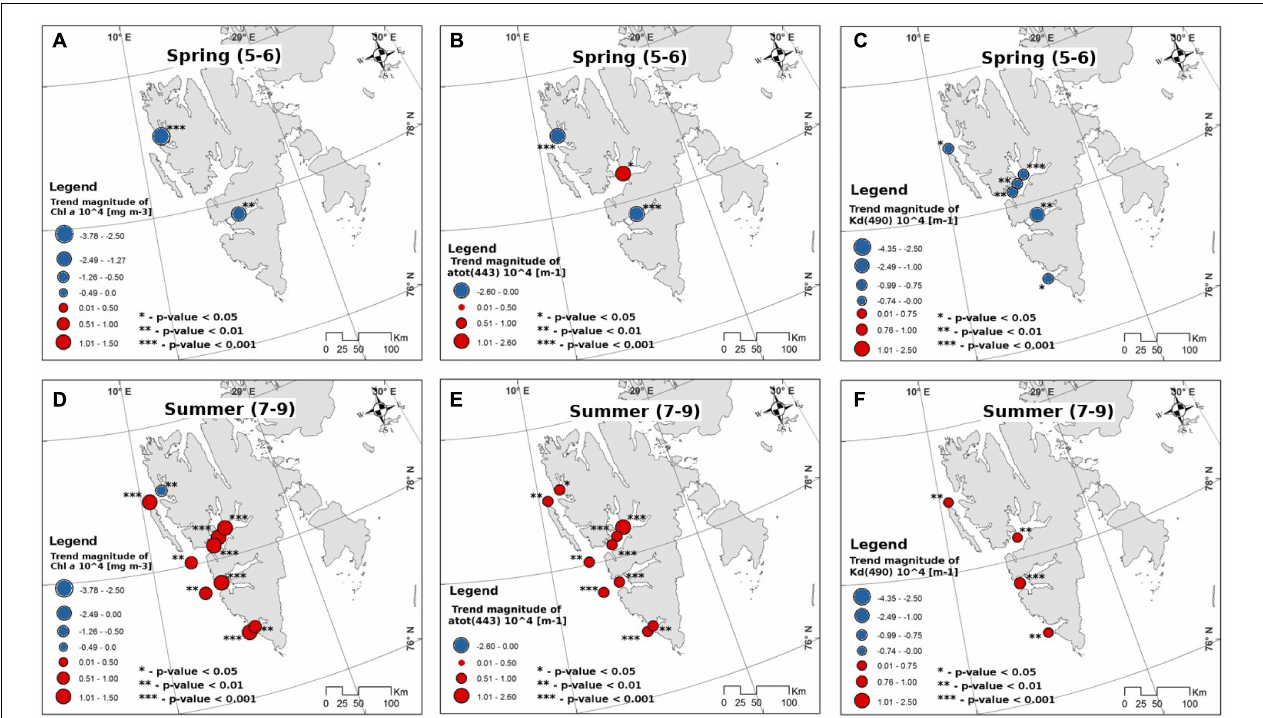
FIGURE 4 | Trends estimates of Chla (A,D) , a tot (443 nm) (B,E) , and K d (490) (C,F) changes throughout the years 1997 – 2019 divided into spring (May – June) and summer (July – September) seasons. * p -value < 0.05; ** p -value < 0.01; *** p -value <